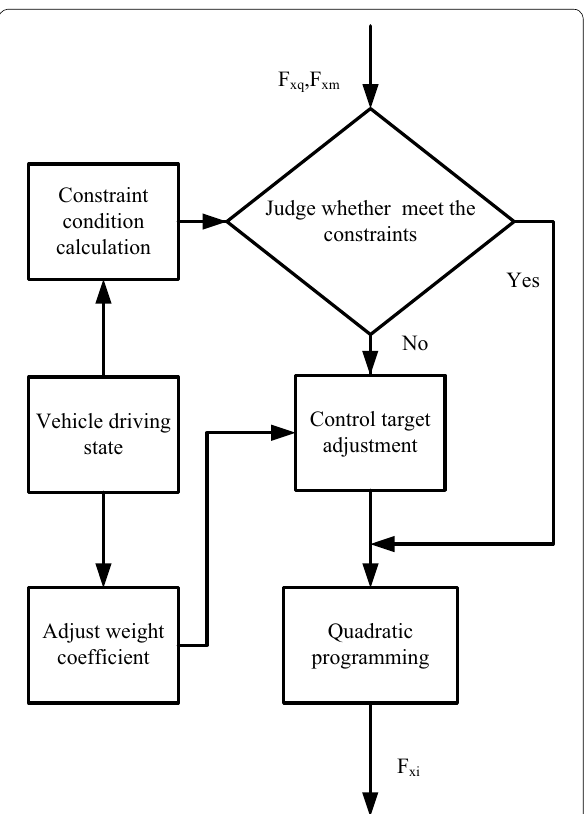
Figure 3 Four-tire longitudinal force distribution algorithm flow